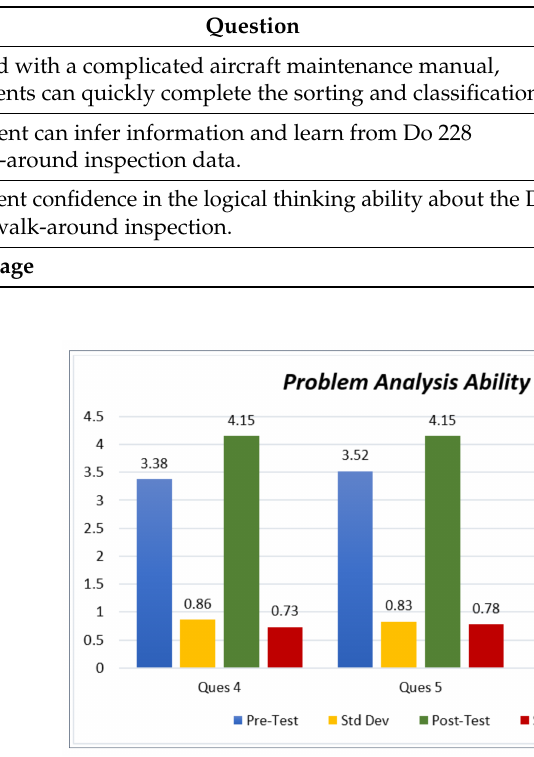
Table 4. The results for the problem analysis ability.